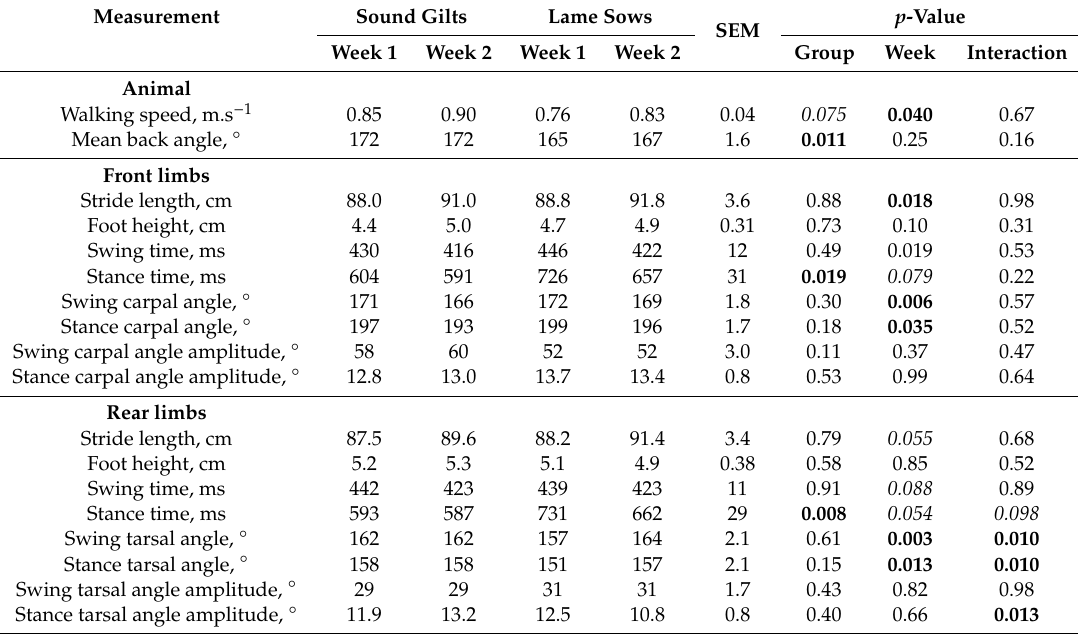
Table 3. Gait characteristics (least square means) of sound gilts and lame sows on the control